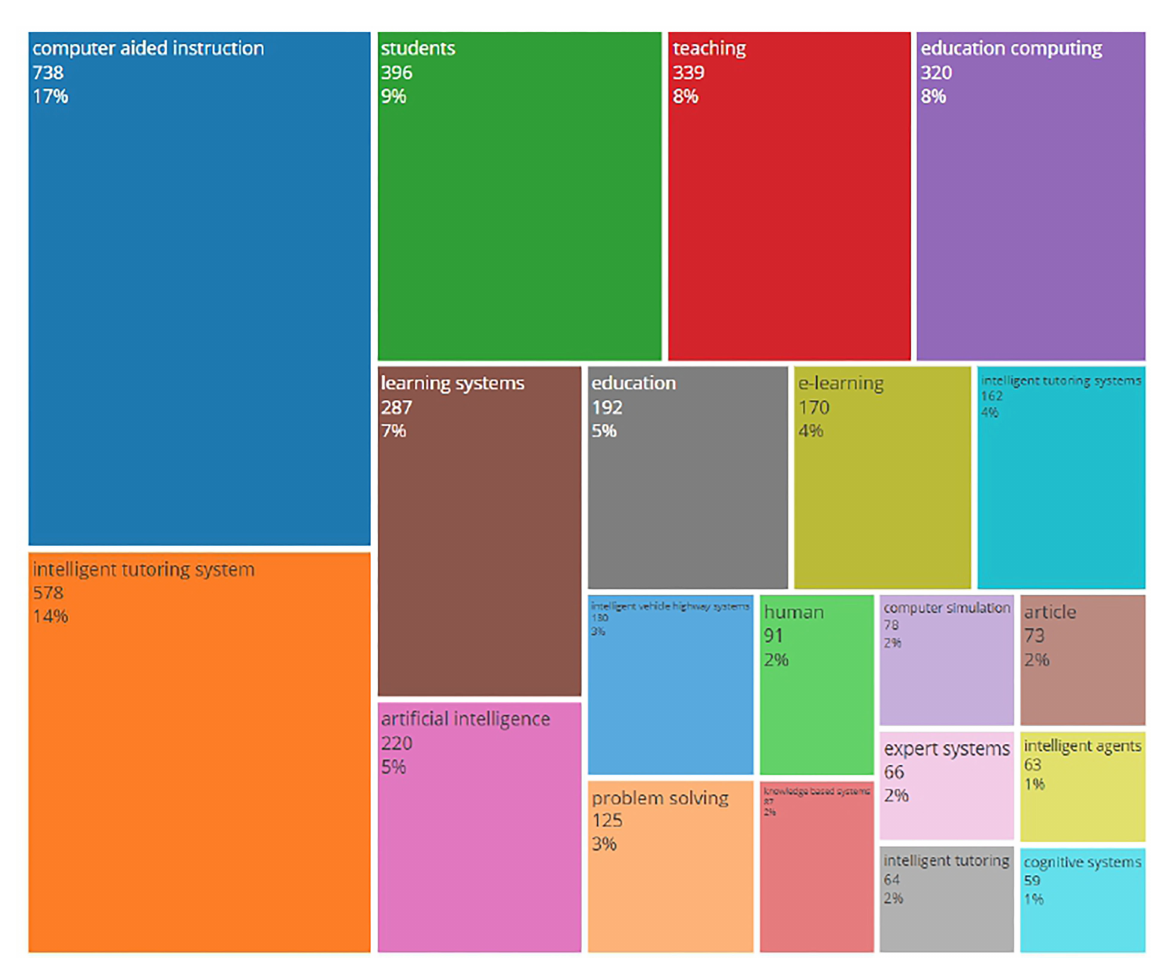
FIGURE4 Percentage of participation based on Keywords